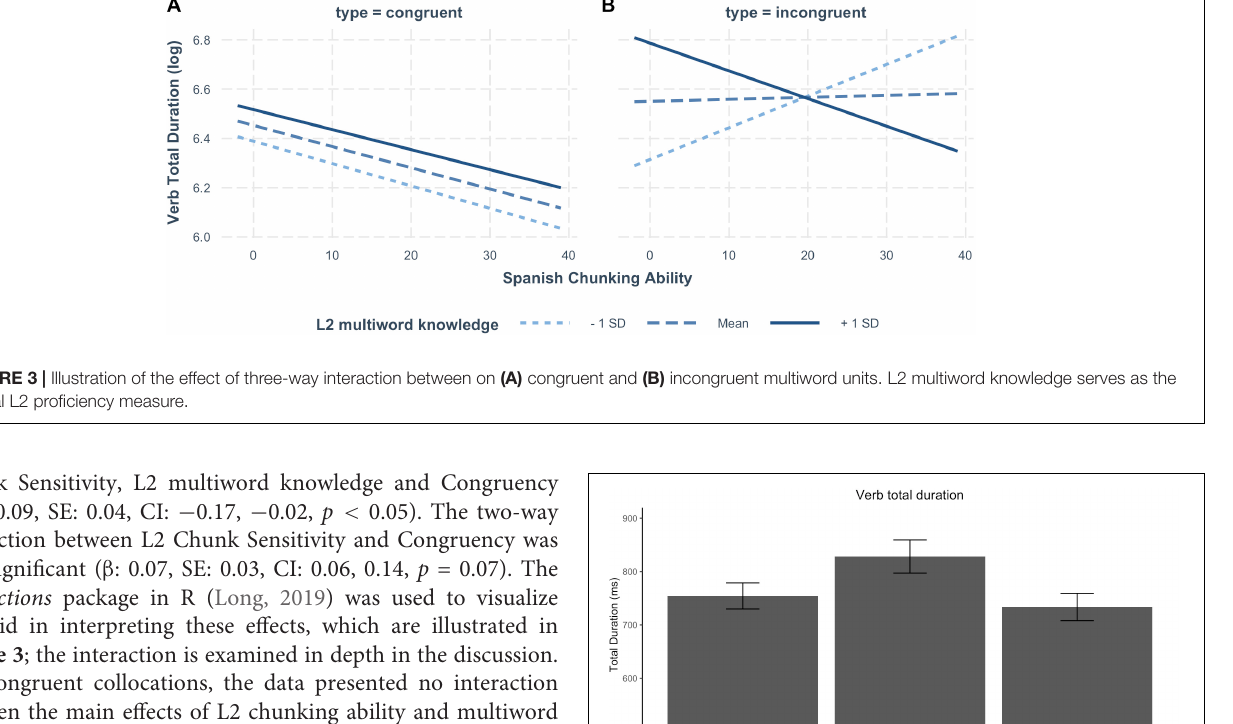
FIGURE 4 | Effect of each tercile of L2 chunking ability on total duration times for the verb. Error bars represent the standard